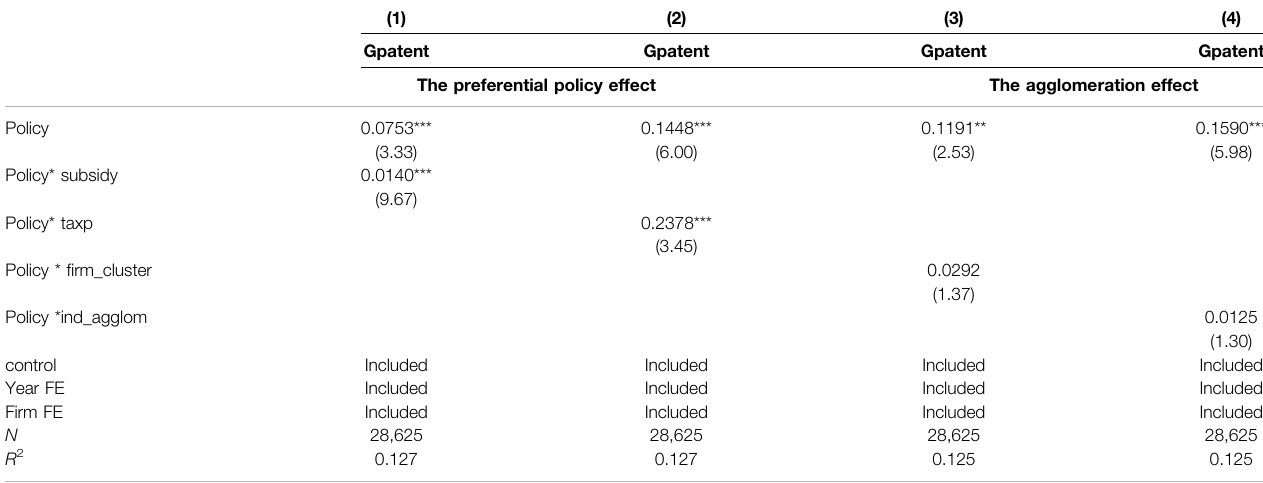
TABLE 6 | Analysis of mechanism: the preferential policy and the agglomeration effect.